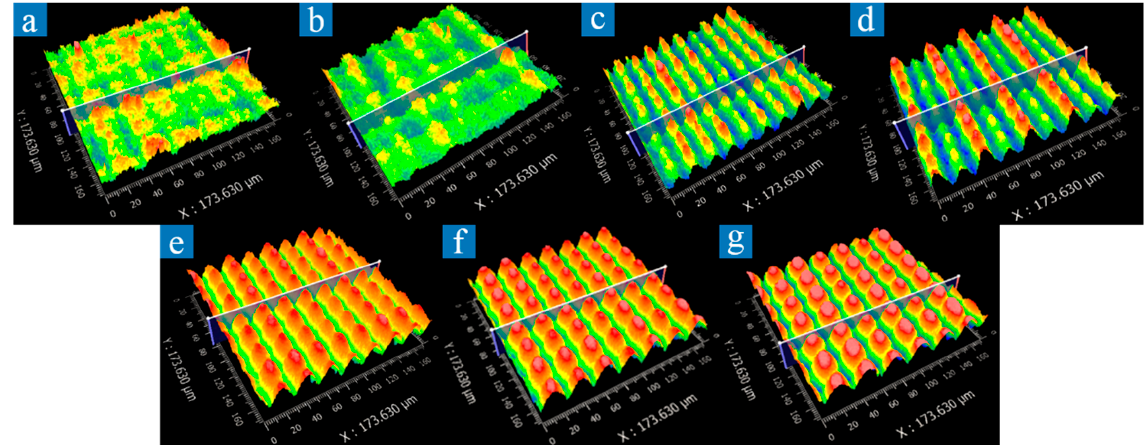
Figure 7. Three-dimensional topography of aluminum alloy surface captured by a white light interferometer under different scanning interval. Length in the images is 173.63 μ m. ( a ) 14 μ m; ( b ) 16 μ m; ( c ) 18 μ m; ( d ) 20 μ m; ( e ) 22 μ m; ( f ) 24 μ m; ( g ) 26 μ m.